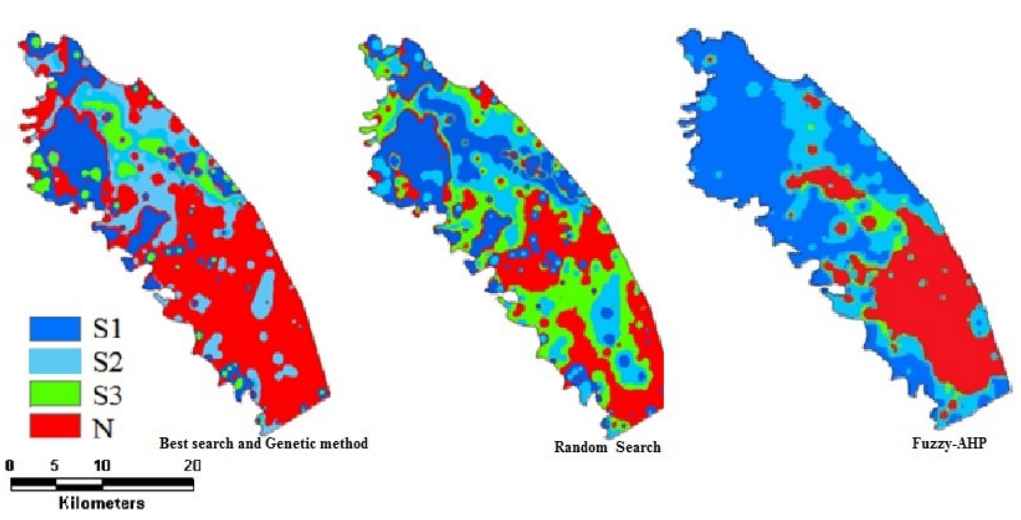
Figure 5. Land suitability maps for barley using the combined method of feature selection and